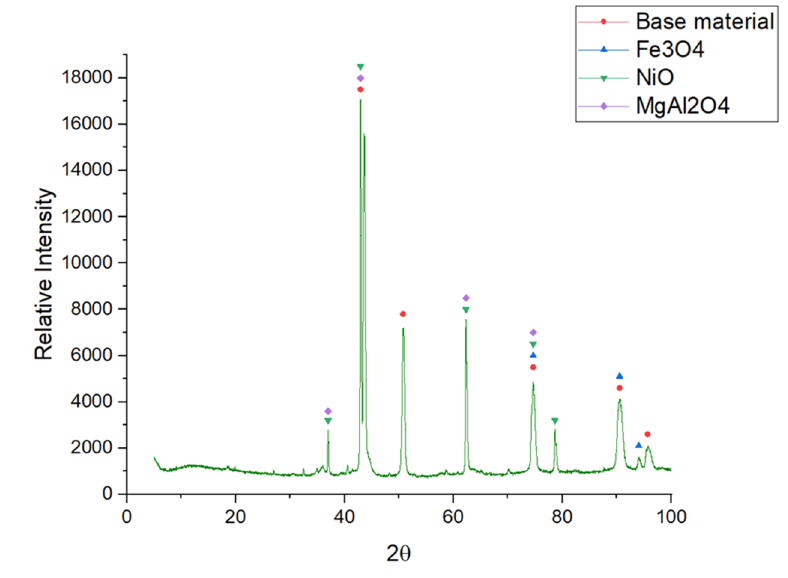
Figure 8. Micrographs showing a top view ( left ) and a cross section ( right ) of OCT immersed in ternary chloride molten salt for 8 h at 720 °C; EDX analysis is shown on top.